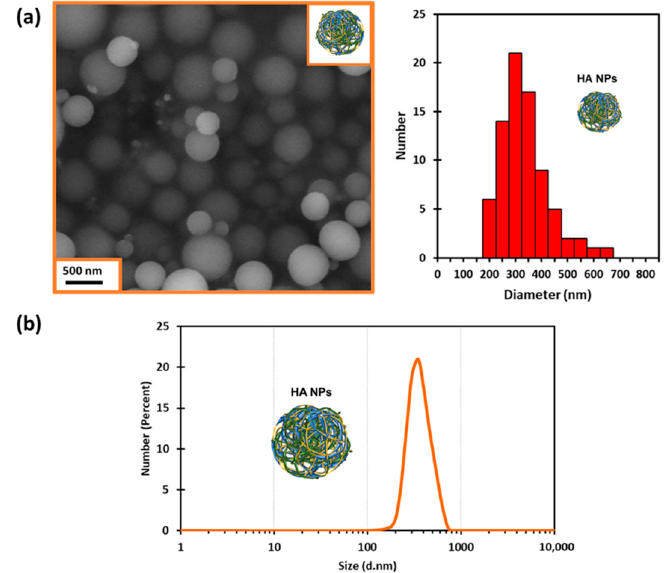
Figure 1. ( a ) SEM images of hyaluronic acid nanoparticles (HA NPs) and their particle size distri- bution, ( b ) DLS analysis of hyaluronic acid nanoparticles (HA NPs) was plotted by the number of nanoparticles as a function of their hydrodynamic diameter.